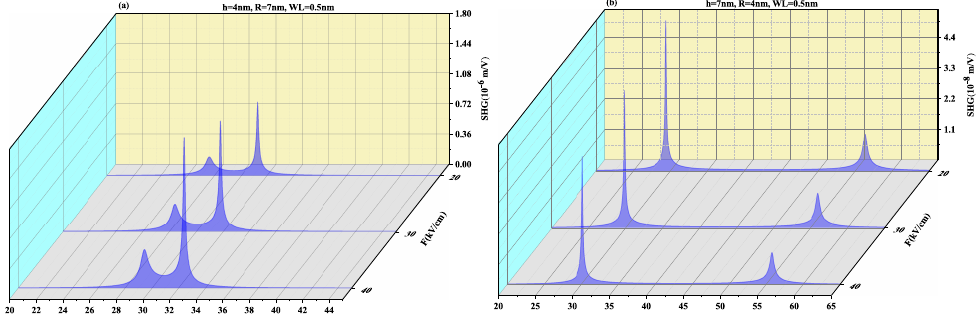
Figure 8. Second harmonic generation as a function of the photon energy for ( a ) oblate height R = 4 nm with radius R = 7 nm at WL thickness 0.5 nm ( b ) prolate QD with R = 4 nm, h = 7 nm with WL thickness = 0.5 nm for different values of the lateral electric field F = 20,30 and 40 kV/cm. Figure 9 displays THG as a function of the photon energy for (a) oblate height R = 4 nm with radius R = 7 nm at WL thickness 0.5 nm (b) prolate QD with R = 4 nm, h = 7 nm with WL thickness = 0.5 nm for different values of electric field F = 20, 30 and 40 kV/cm. In oblate QD (Figure 9a), with an increase in the electric field strength, the two resonance peaks tend to merge with increasing the electric field strength whereas Figure 9b shows that the resonance peaks are distant. Blueshift is also visible in the pinnacle with a rise in magnitude but in Figure 9b prolate QD, no shift is observed in peaks with an increase in strength of the electric field. However, the amplitude of peaks suffers a decrease with an increase in strength of the electric field. THG coefficients for CdS [71] QD (10 − 17 m 2 /V 2 ) and for the SiGe case are near to the GaAs/AlAs case (10 − 14 m 2 /V 2 ) as reported by Reference [72].